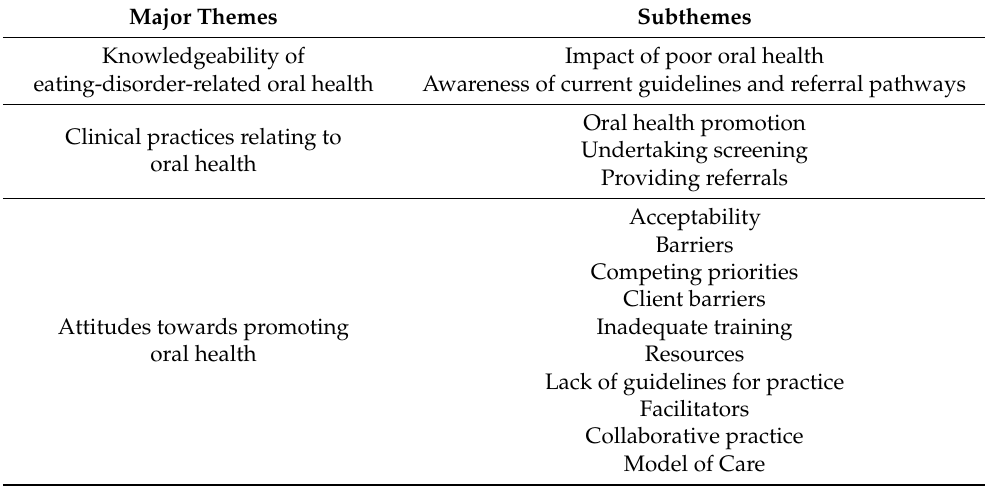
Table 1. Major themes and